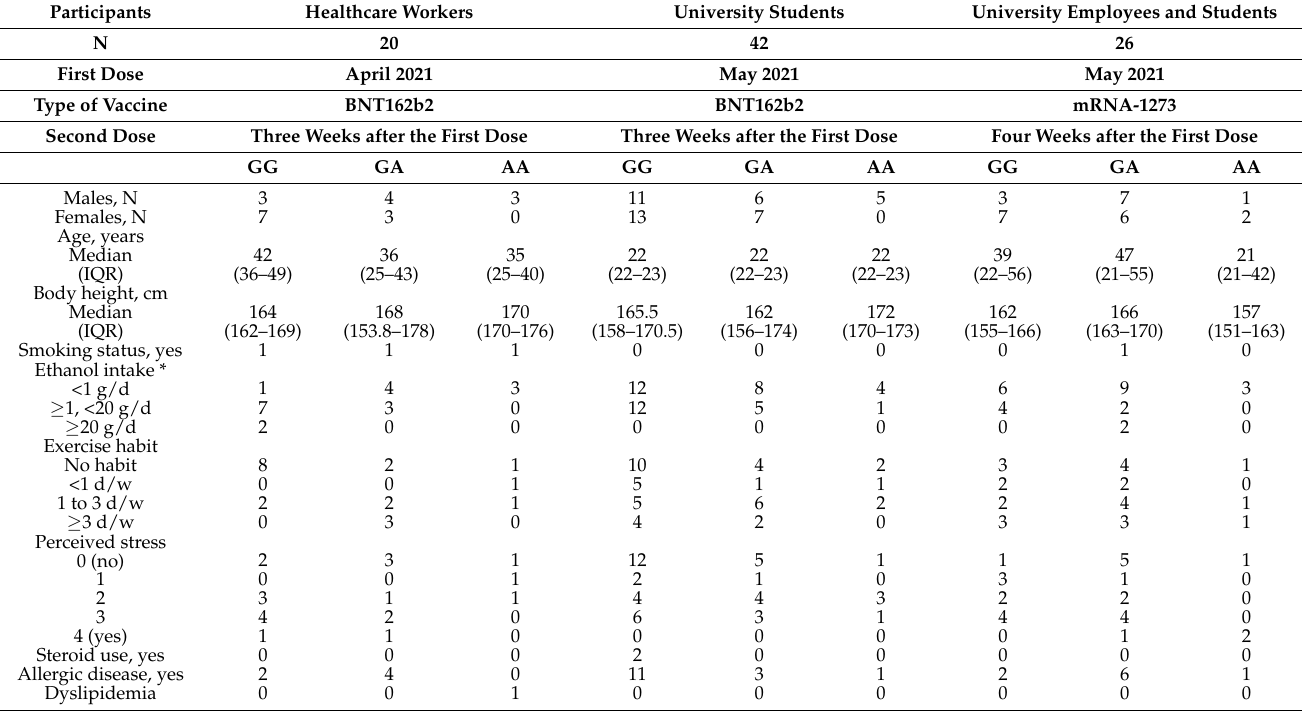
Table 1. Baseline characteristics of participants for ALDH2 rs671